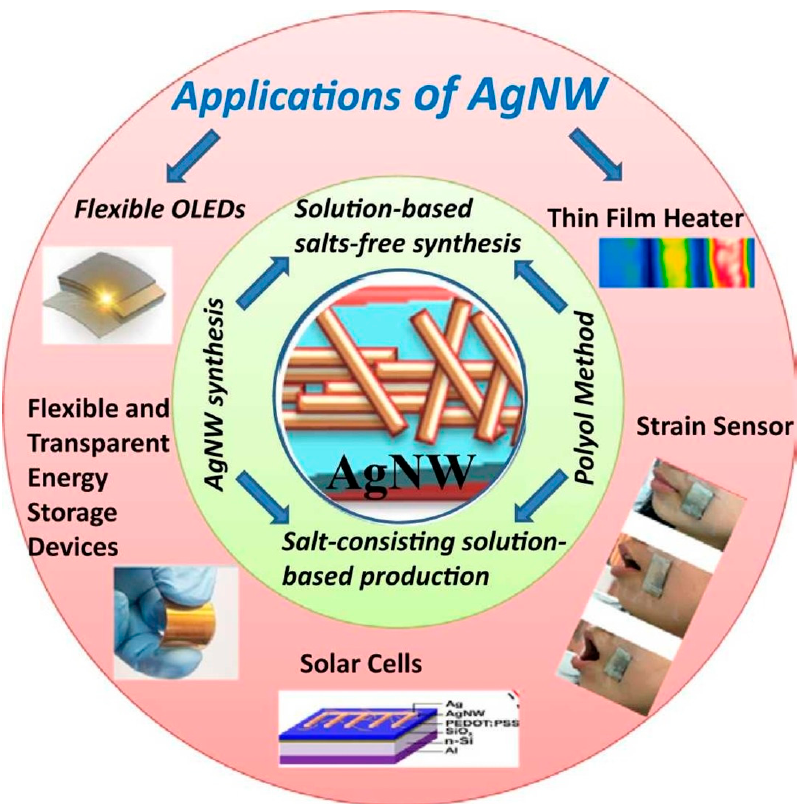
Figure 1. Schematic of various application areas of Ag nanowires. Reproduced with permission from Ref. [22]. Copyright 2022, Elsevier.